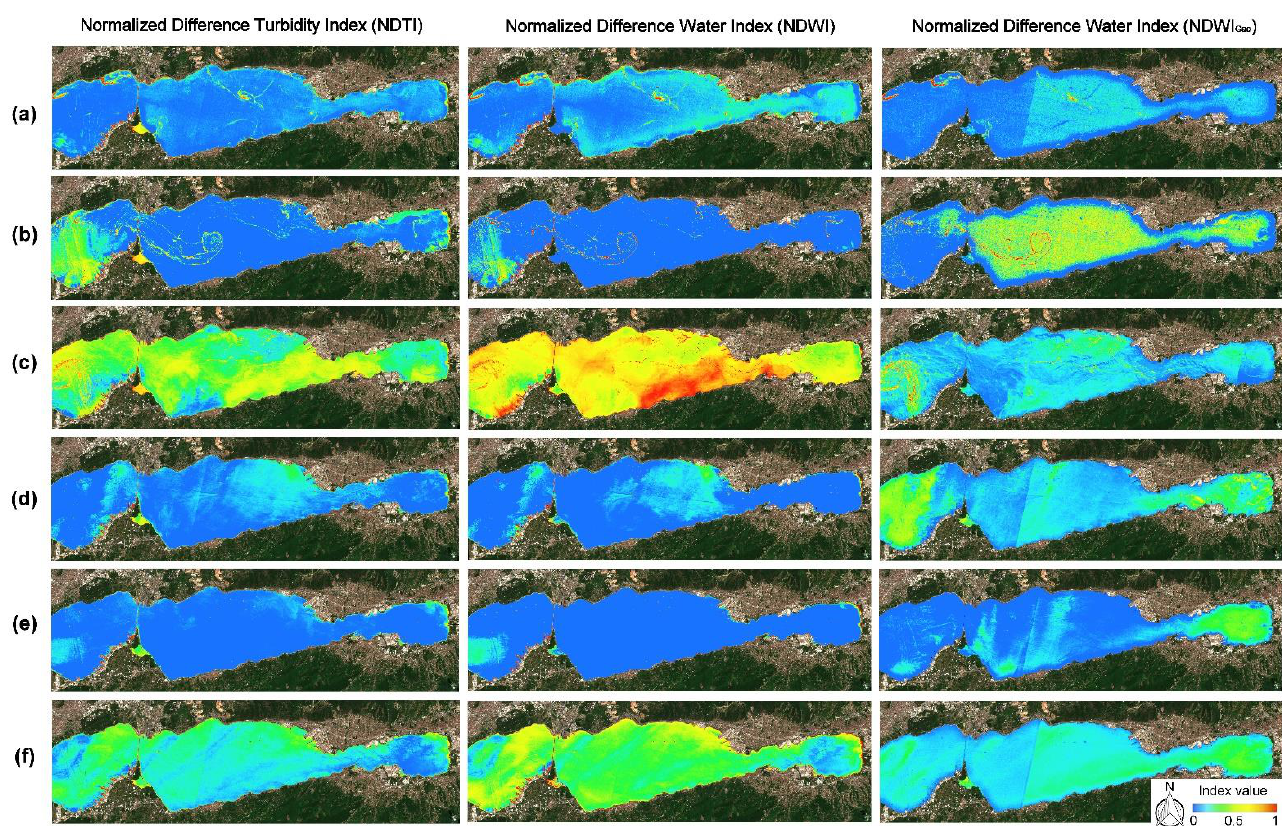
Figure 4. Estimated thematic maps of NDTI, NDWI and NDWI Gao from Sentinel-2 images acquired on ( a ) 14 May; ( b ) 19 May; ( c ) 24 May; ( d ) 13 July; ( e ) 18 July; ( f ) 28 July 2021.